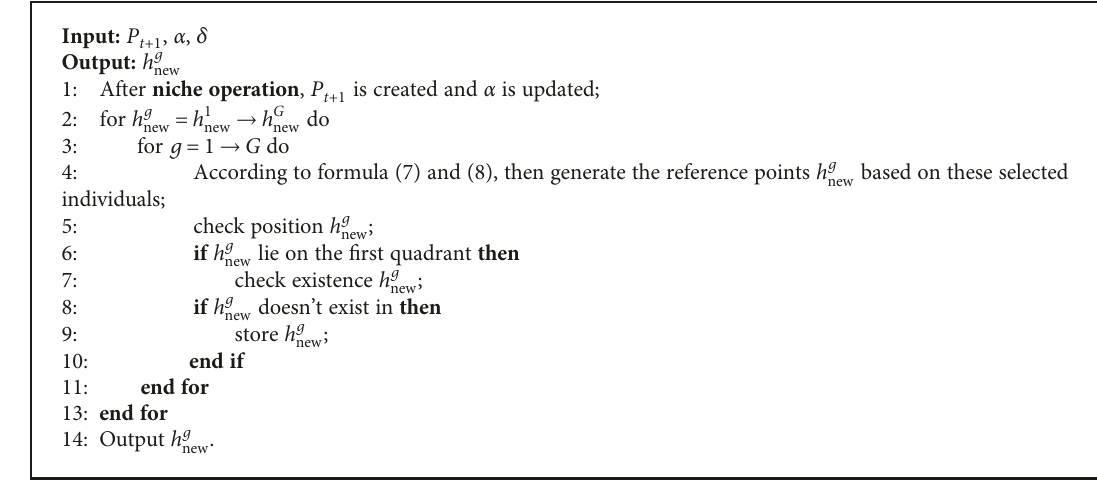
Algorithm 1: Generation of New Reference